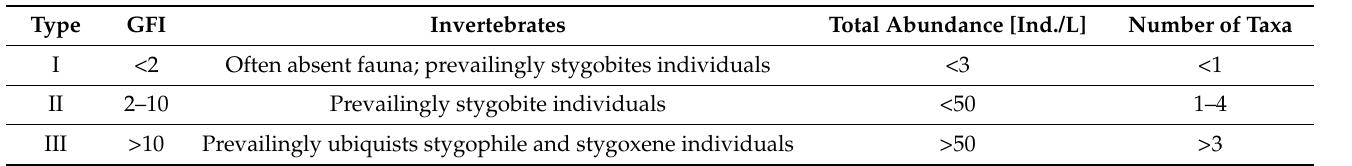
Table 2. Values of GFI according to